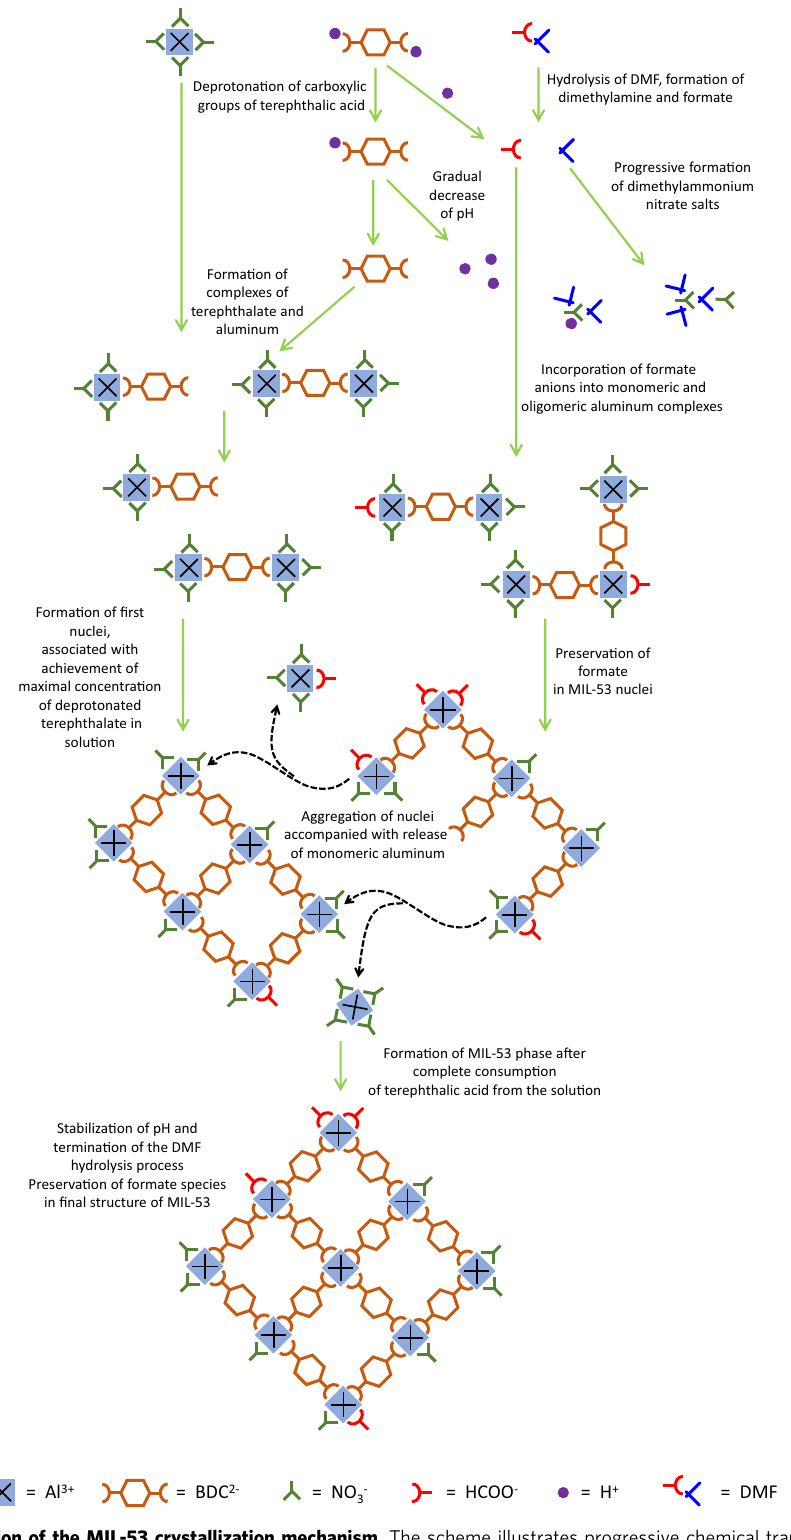
Fig. 5 Schematic representation of the MIL-53 crystallization mechanism. The scheme illustrates progressive chemical transformations of molecular precursors leading to the solid MOF